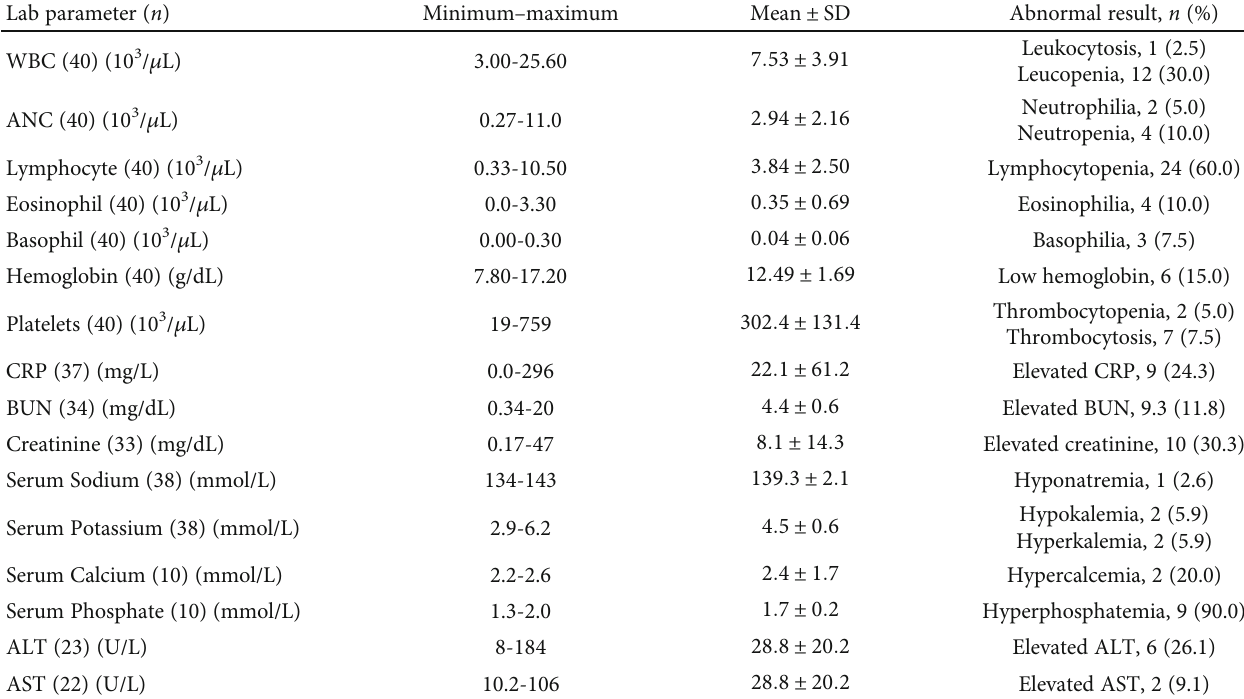
Table 3: Lab parameters.